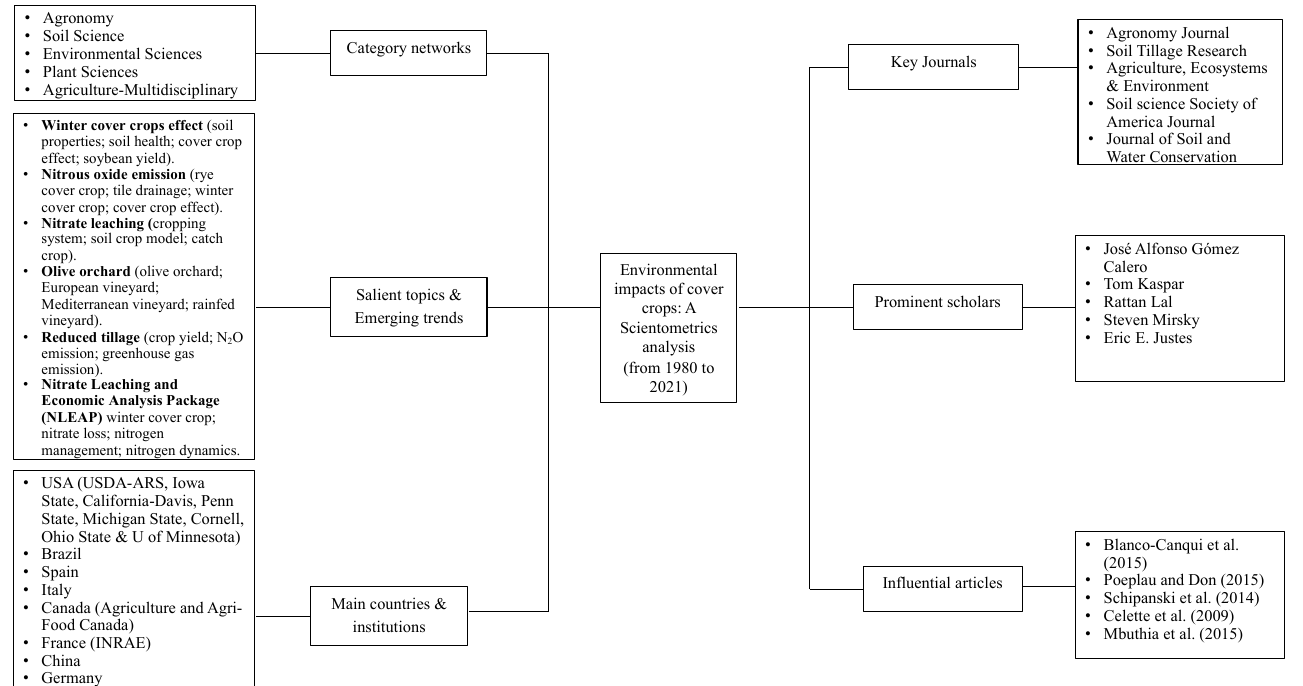
Figure 10. Mind map of this paper.